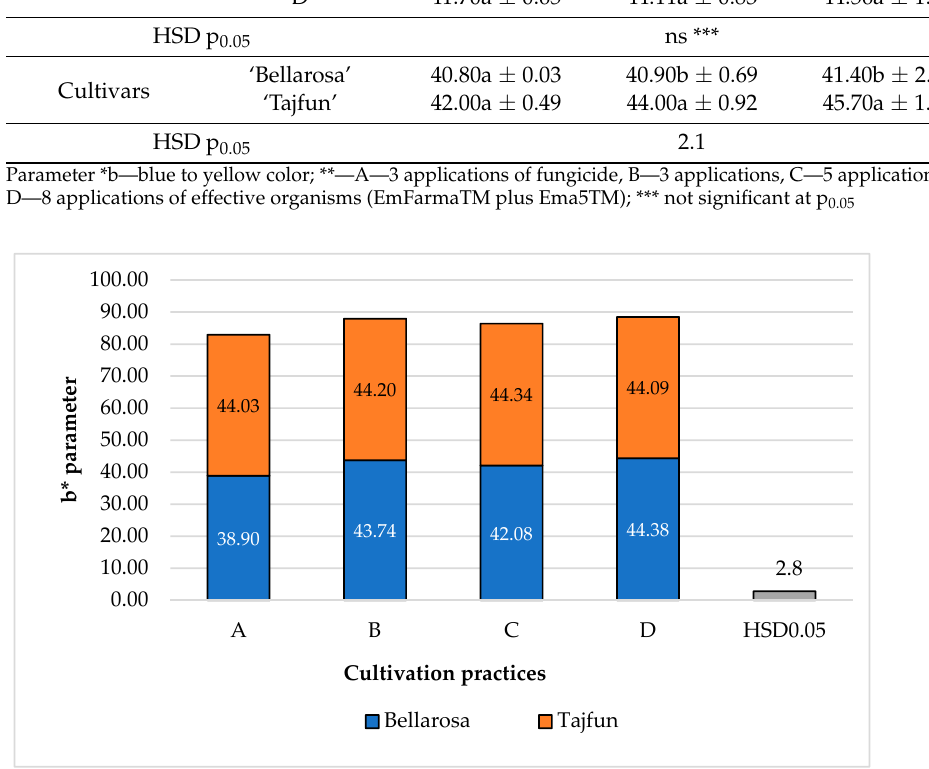
Figure 8. Effects of cultivation practices and cultivars on the value of b* parameter of raw tubers. Cultivation practices: A—3 applications of fungicide, B—3 applications, C—5 applications, and D—8 applications of effective organisms (EmFarma TM plus Ema5 TM ).